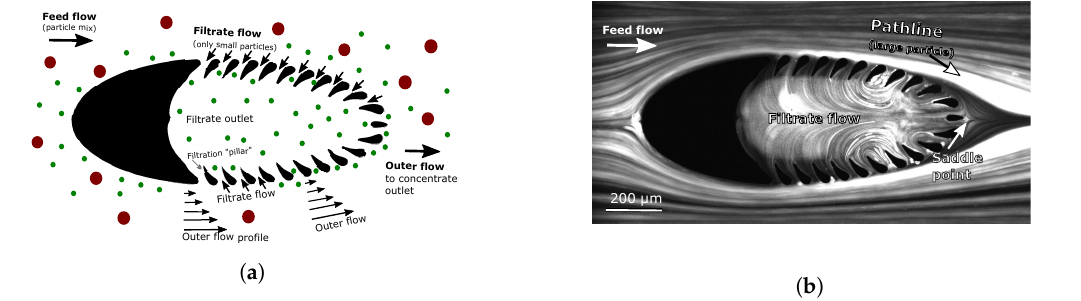
Figure 2. ( a ): Cartoon showing a clog-preventive flow configuration: the flow is mostly parallel to the filter blades to minimize interactions with these. ( b ): Pathline representation showing the trajectory of large separation spheres (around 30 µ m) and the flow fields (obtained using 1 µ m tracers) around a single filtration unit: due to particle inertia, which is achieved by pumping the fluids at high rates through the channels, the large spheres separate from the flow upstream of the so-called saddle